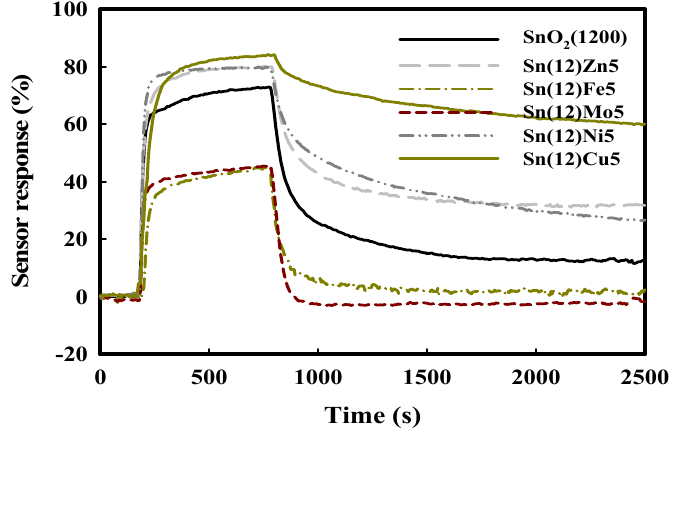
Figure 4. Response curves of the SnO S concentration of 1.0 ppm at 350 oxides at a H 2